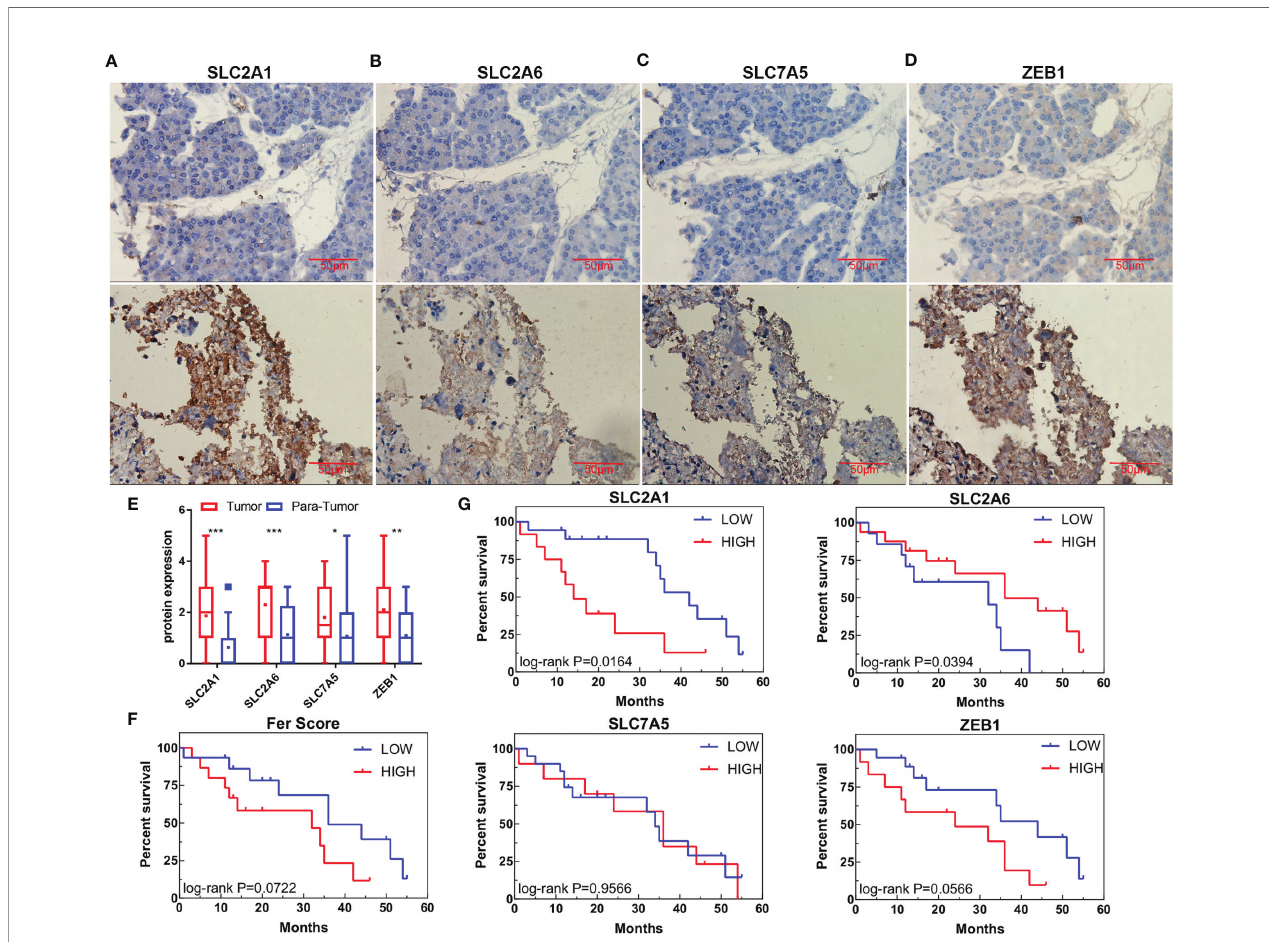
FIGURE 7 | Protein expression and survival according to genes in the Fer-score model. (A – D) The expression of SLC2A1, SLC2A6, SLC7A5, and ZEB1 in adjacent tissues (top panel) and tumor tissues (bottom panel). (E) Statistical graphs of adjacent tissues and tumor expression. (Bar, 50 m m) (F) Survival curve based on the Fer-score model. (G) Survival curve according to the protein expression of the four genes. *p < 0.05, **p < 0.01, ***p <